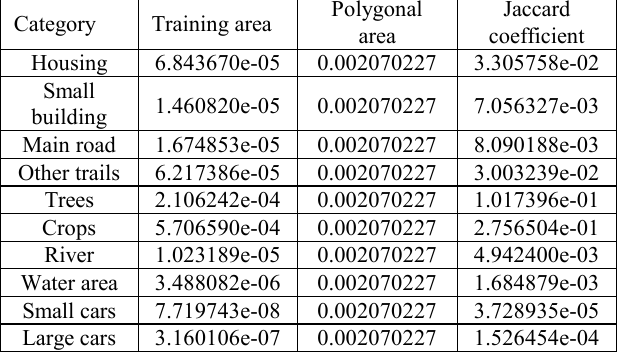
Table 2 The Jaccard coefficient of training